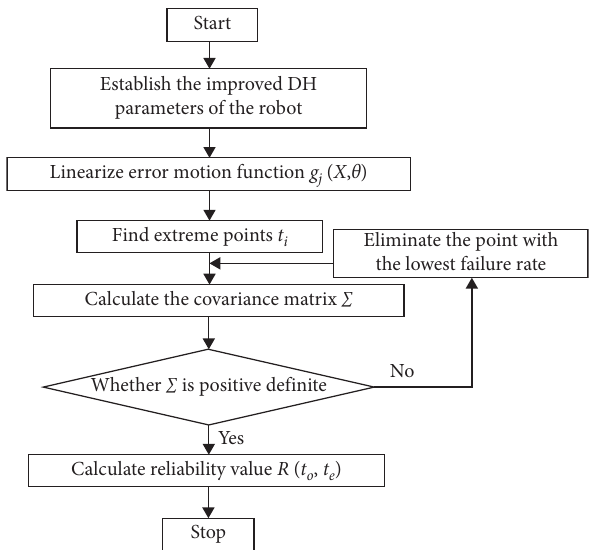
Figure 4: Flowchart of the envelope method.